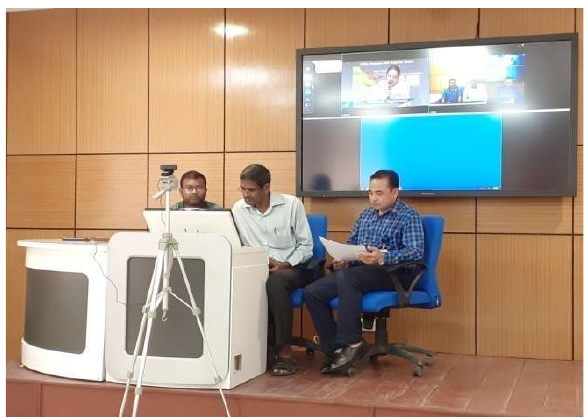
Figure 3. Inauguration of NESAC- IIRS joint course on April 29, 2019 at NESAC with IIRS and participants video conferencing